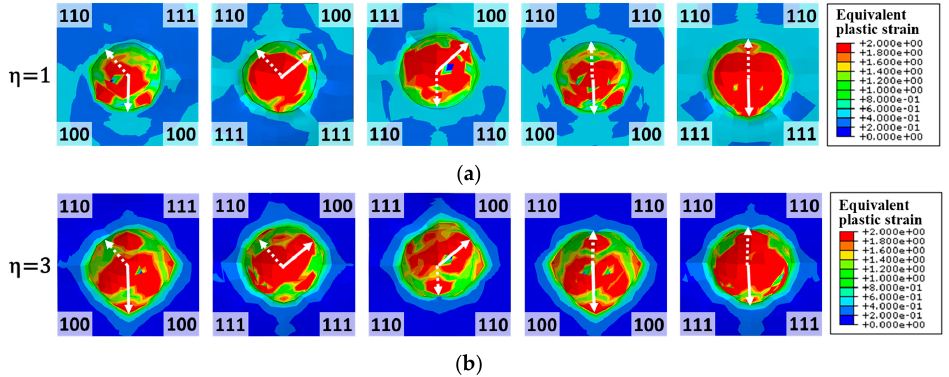
Figure 6. Growth of voids embedded in bi- and tri- crystals. The dotted arrow indicates the slowest void growth direction, while the solid arrow represents the fastest void growth direction. The orientations are denoted at the corner of each cell: ( a ) for a constant stress triaxiality of 1, ( b ) a constant stress triaxiality of 3. The color code represents the equivalent plastic strain (red denotes high strain